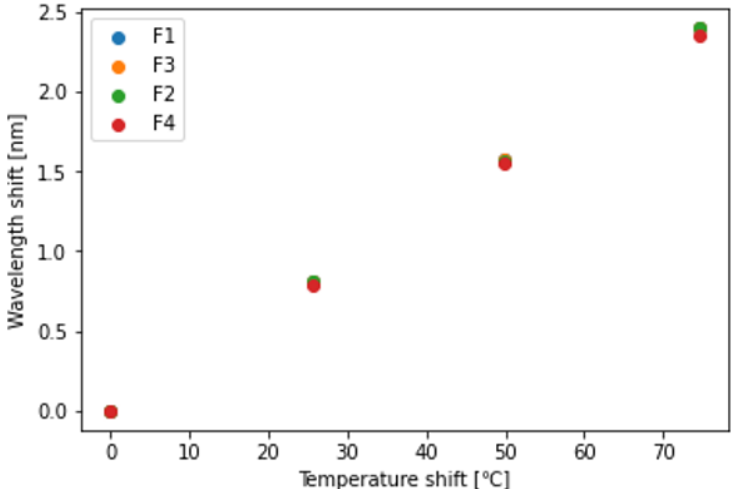
Figure 6. Bragg wavelength shift as a function of strain.